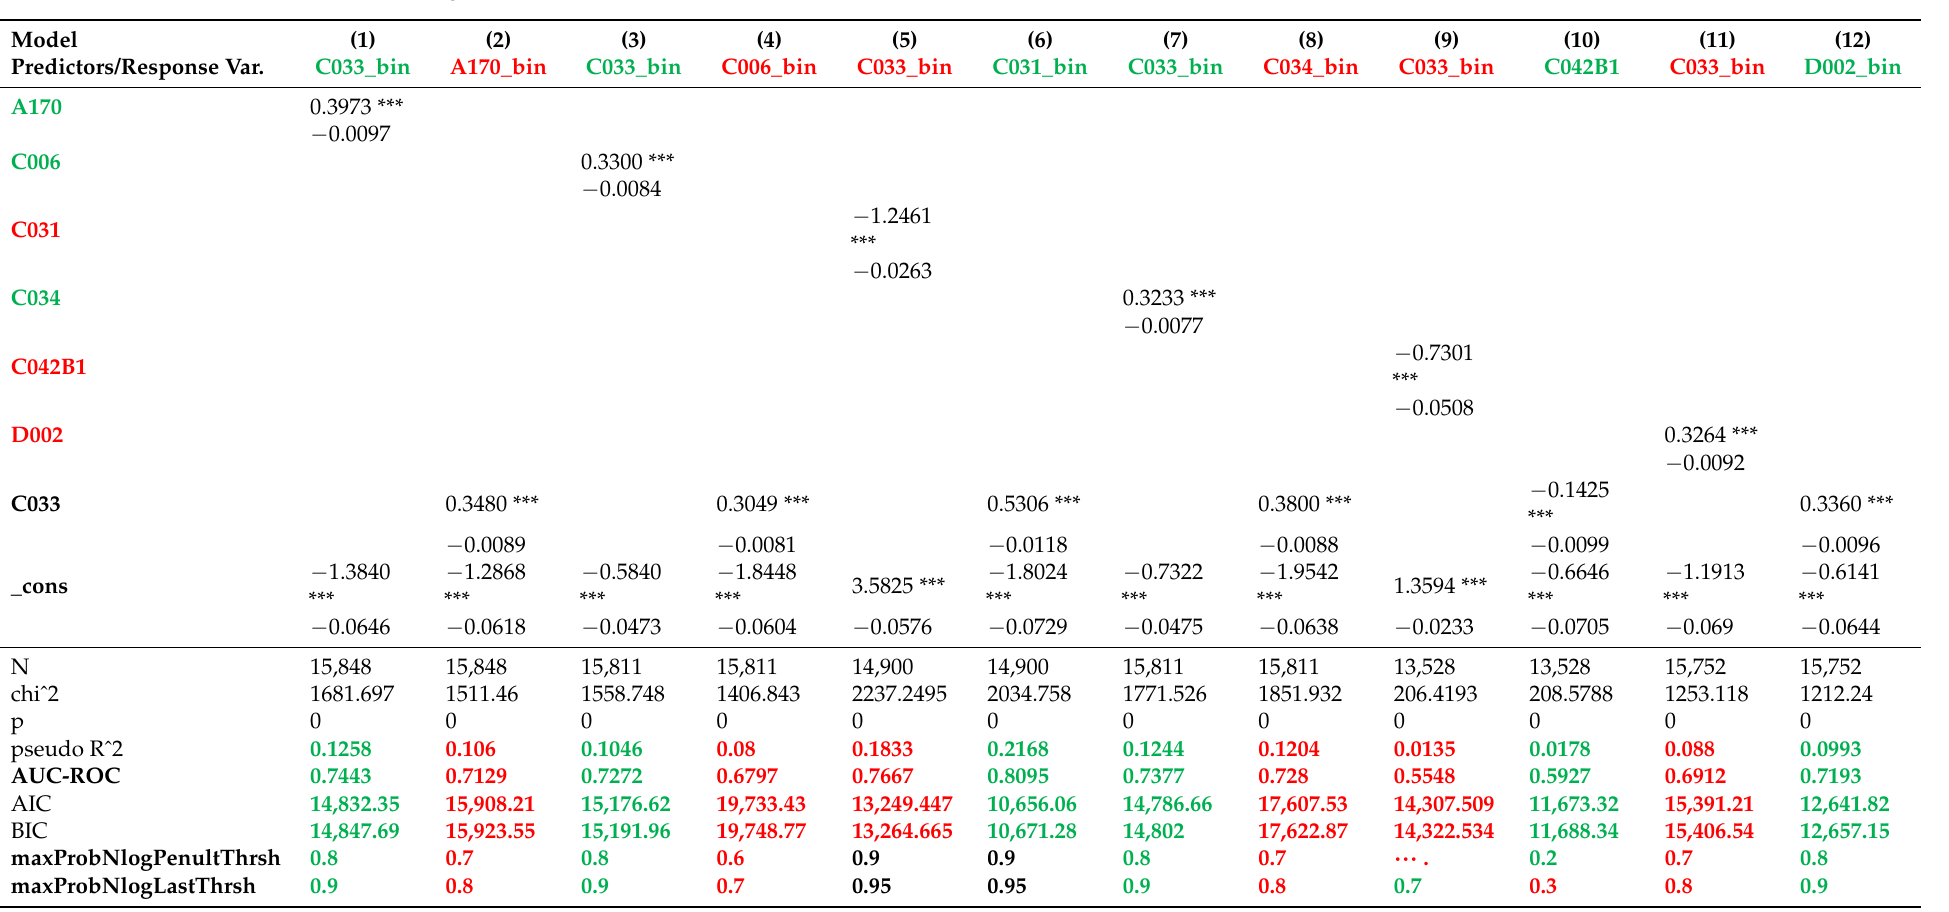
Table A3. Comparative reverse causality checks using logistic regressions for job satisfaction and each potential predictor from the 6 resulting from the 2nd round mining.